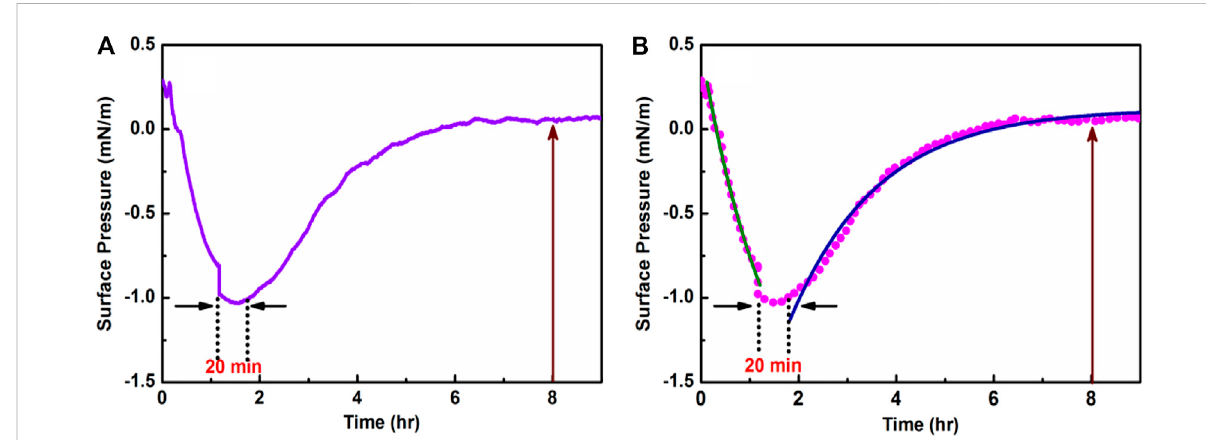
FIGURE 1 (A) RoomtemperatureadsorptionkineticsofHC-CtDNAattheair-waterinterface. (B) Thedescending(greentrace)andascending(bluetrace) regions of the fi tted π — t plot.